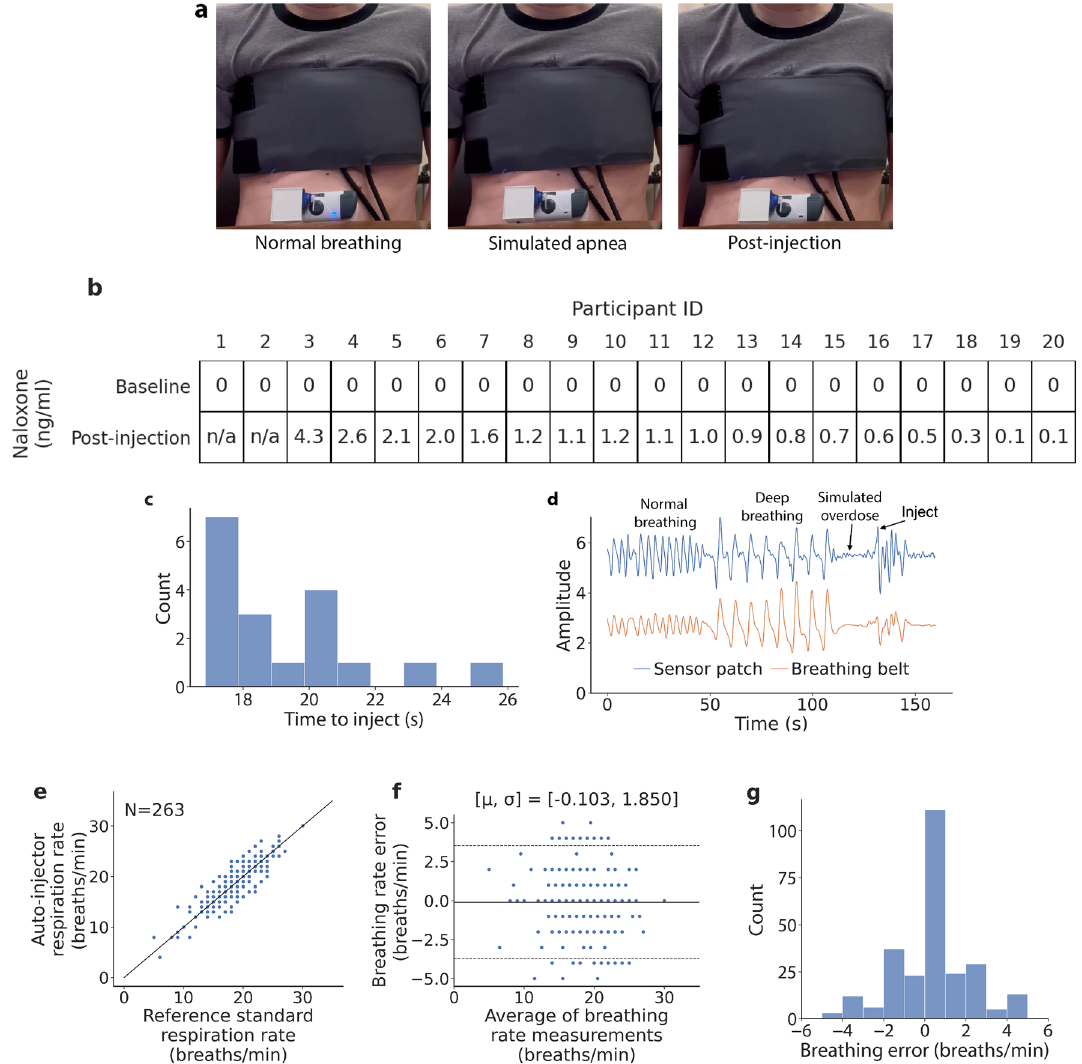
Figure 3. Naloxone delivery in simulated laboratory environment. ( a ) Depiction of participant in laboratory with wearable device and breathing belt. Participant engages in normal breathing, followed by a simulated apnea which activates the injector. ( b ) Naloxone levels in participant blood samples before and after injection. ( c ) Histogram of the time taken for the sensor patch to detect the onset of a simulated overdose and activate the injector. ( d ) Breathing signal from sensor patch and breathing belt showing a simulated apnea and activation of the injector. ( e ) Correlation and ( f ) Bland–Altman plots comparing breathing rate from respiration belt and wearable sensor patch. ( g ) Histogram of breathing rate